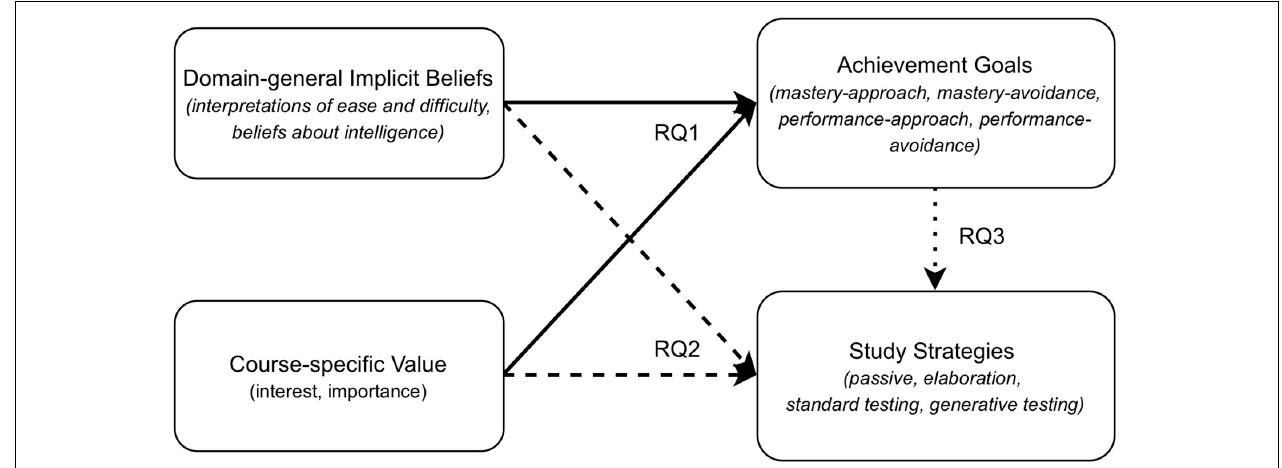
FIGURE 1 | Diagram representing three key research questions. Research Question (RQ) 1 is represented by the solid arrows, RQ2 is represented by the dashed arrows, and RQ3 is represented by the dotted